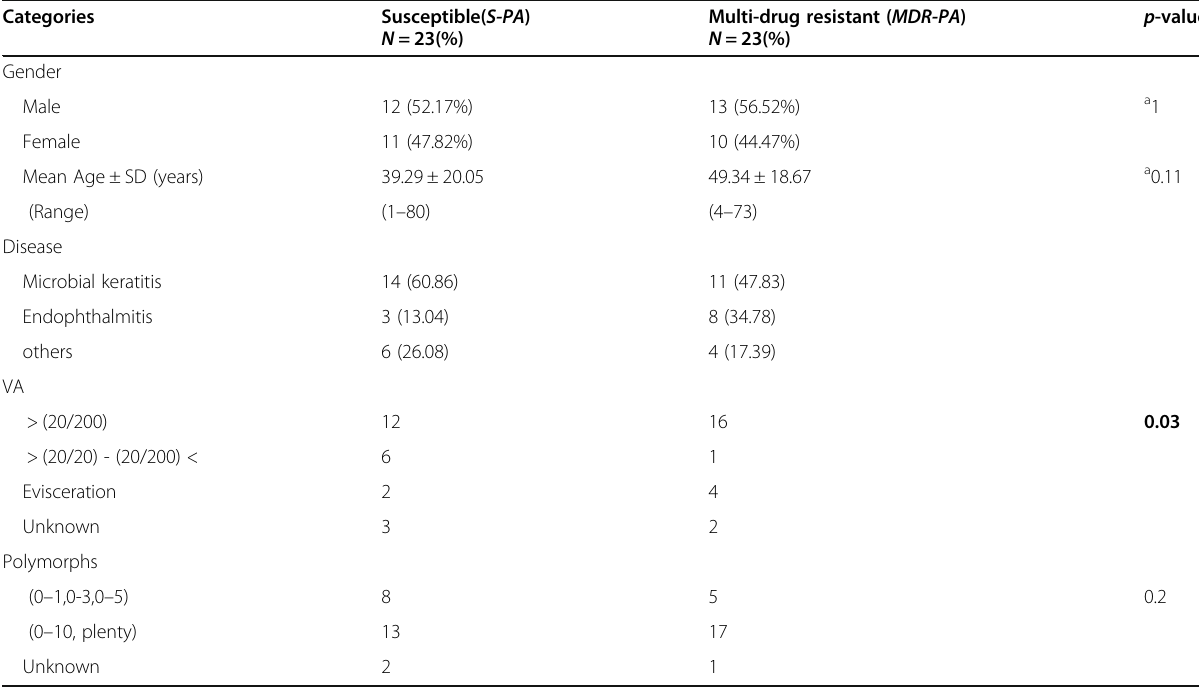
Table 1 Demographic and microbiological data of the patients included in the